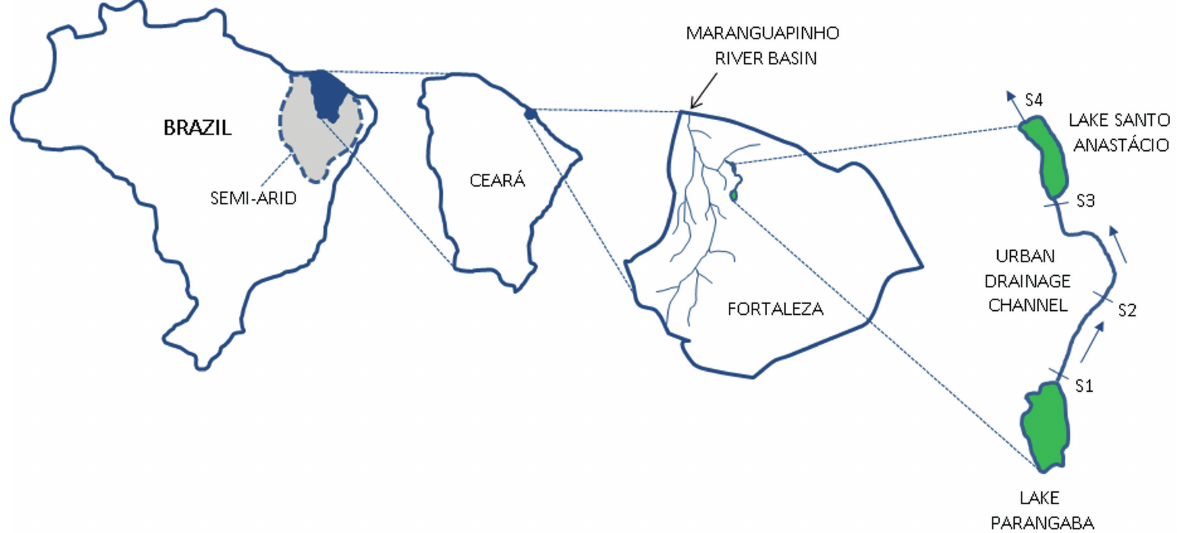
Figure 1 - Schematic of the urban drainage channel-shallow reservoir system located within the Maranguapinho river Basin, in the city of Fortaleza, Ceará State (Brazilian semiarid). Measurement sections S1 – S4 are also indicated.